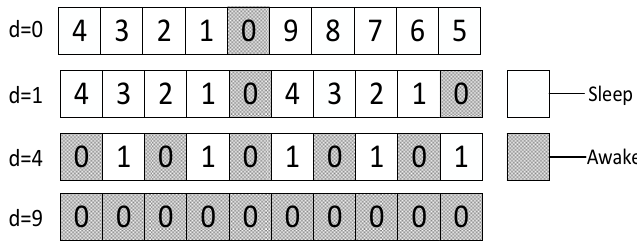
Figure 10. Example of the effect of added slots on empty delay ( m = 10).